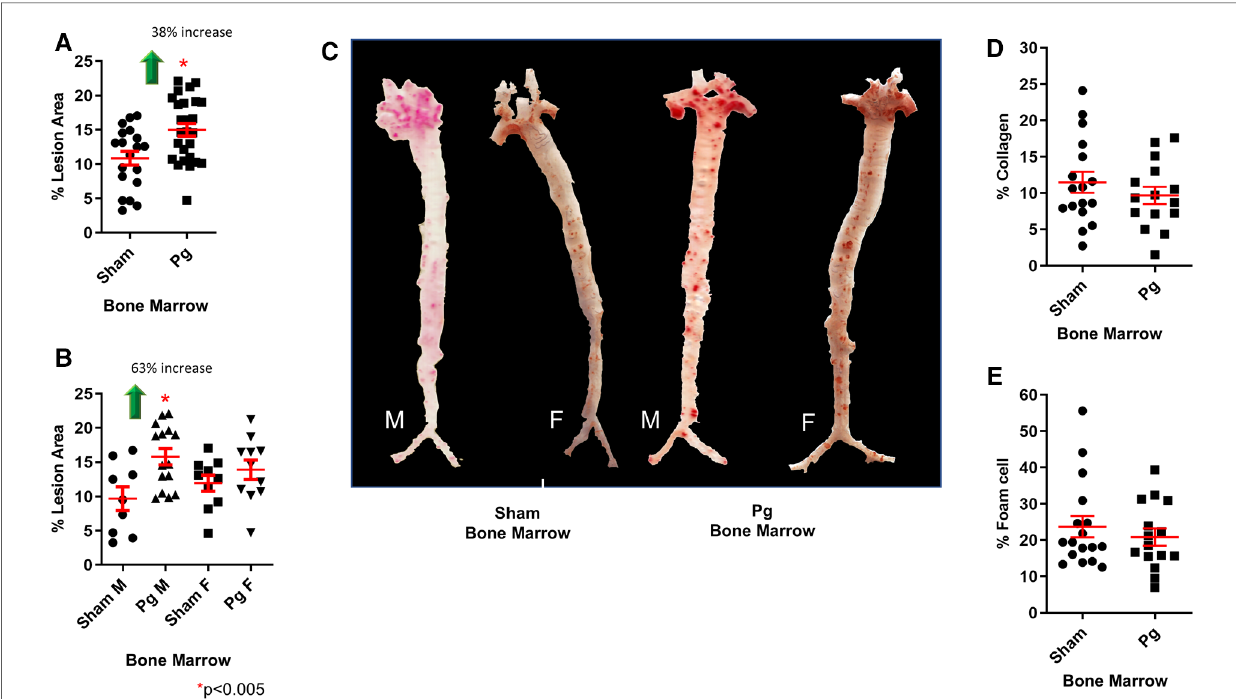
FIGURE 2 ( A ) En face morphometric analysis of oil red O-stained aortae showed a signi fi cant 38% increase in lesion area in mice that received BM from Pg - inoculated donor mice compared with those that received BM from sham-inoculated donors. ( B ) Sex-speci fi c analysis showed a signi fi cant 63% increase in male mice that received BM from Pg -inoculated donor mice compared with those that received BM from sham-inoculated donors. There was no signi fi cant difference between the female groups. M=male; F=female; n =9 – 15/group. (C) Oil red O-stained aortae from the groups. ( D ) Percent collagen content and ( E ) percent foam cell in similarly sized lesions from the aortic sinus ( n =5/group).